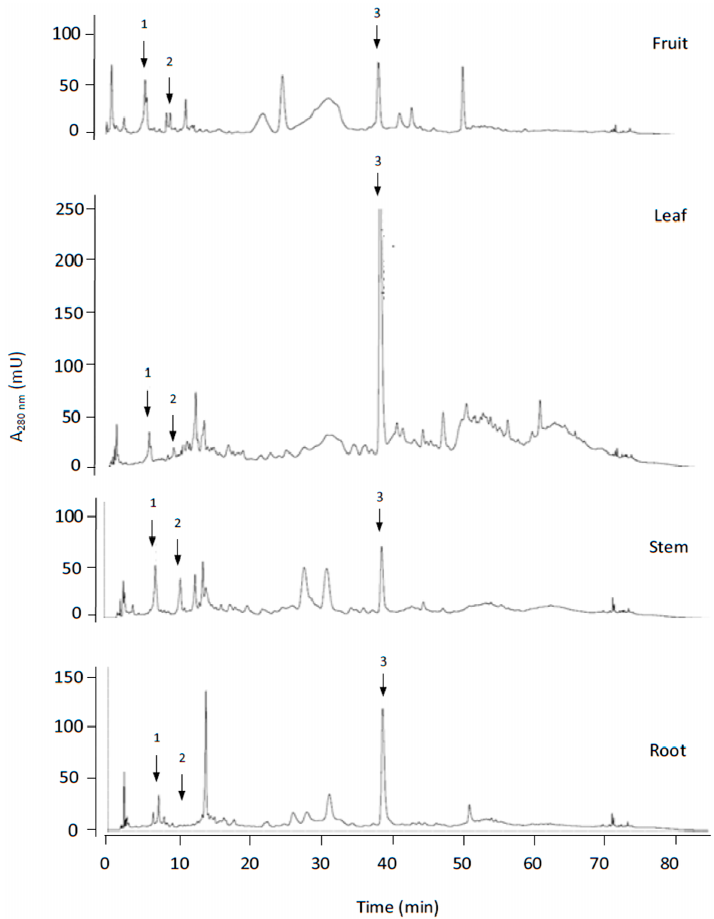
Figure 5. Chromatograms obtained after reverse phase HPLC-UV / Vis analysis of fruit, leaf, stem and root olive tree phenolic extracts. Compound 1: hydroxytyrosol, 2: tyrosol, 3: oleuropein.